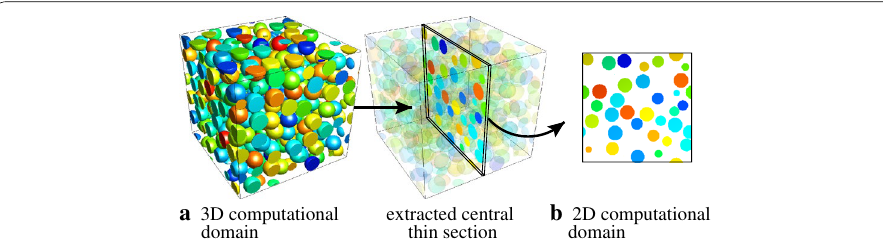
Fig. 2 Initial fillings of 2D and 3D computational domains. a 3D seeds of grains resulting from the distribu- tion generating algorithm. b 2D computational domain obtained by extracting a thin (central) section of the 3D domain